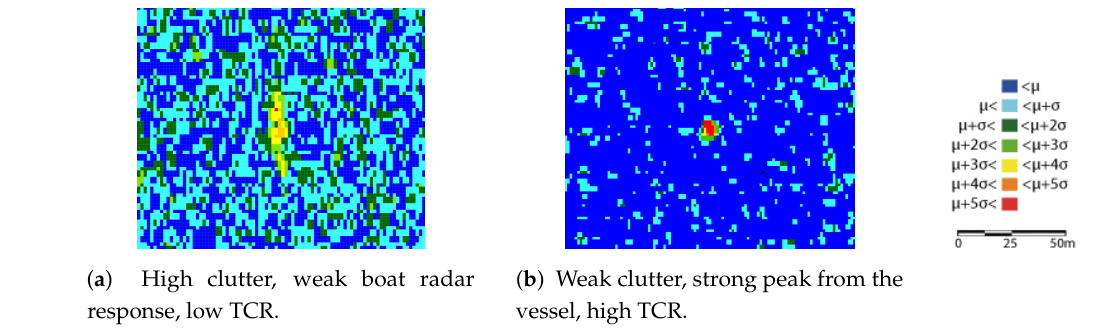
Figure 13. Examples of the vessel’s radar footprint in TSX-HS mode (©DLR, 2017).